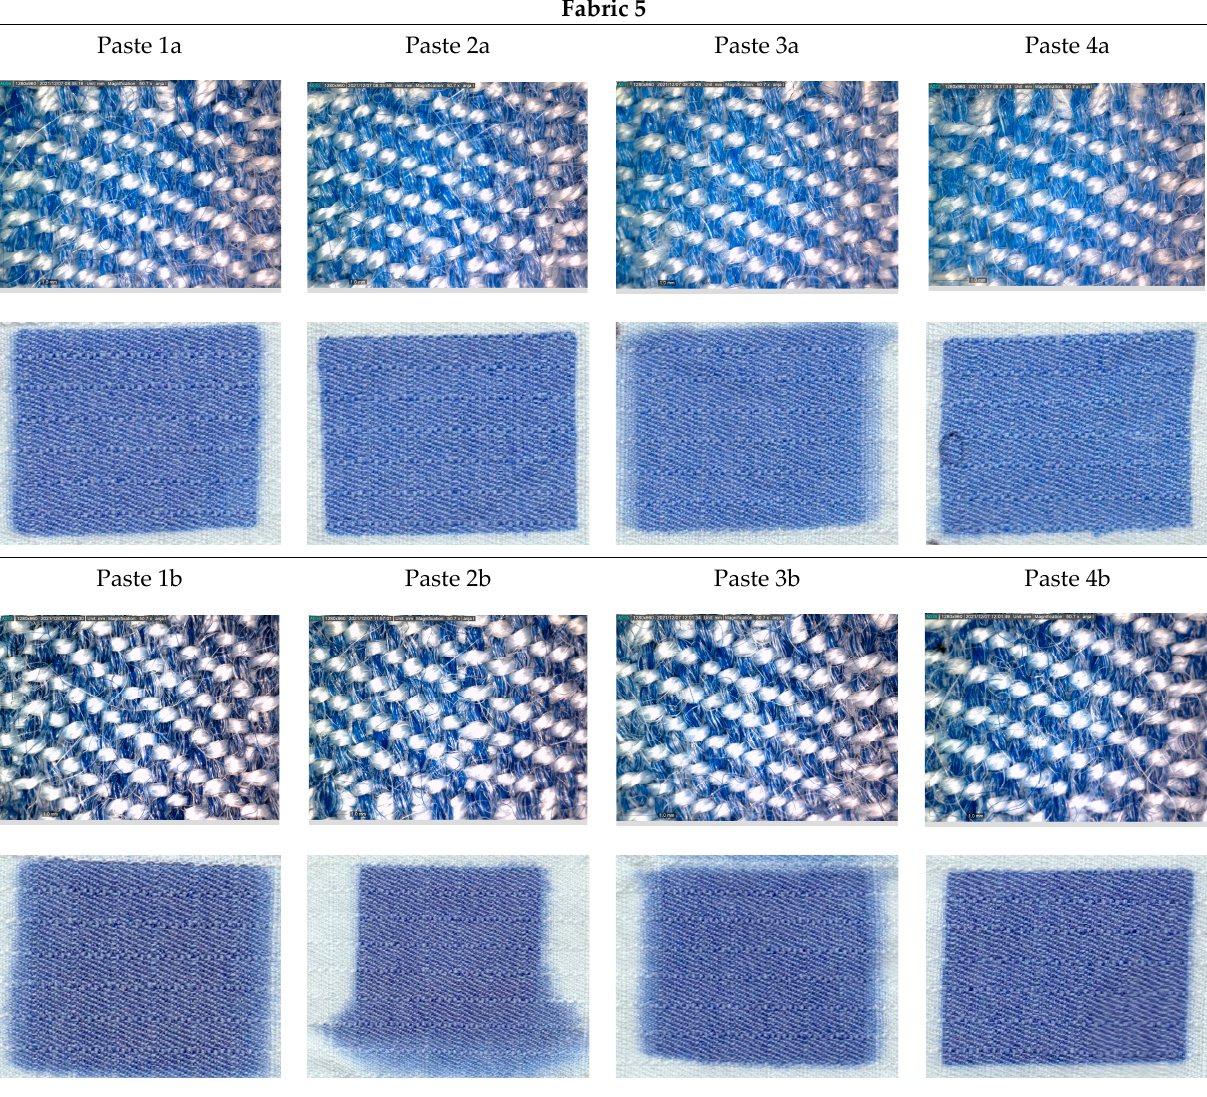
Figure 5. DinoLite microscopic and scanned images of printed Fabric 5.